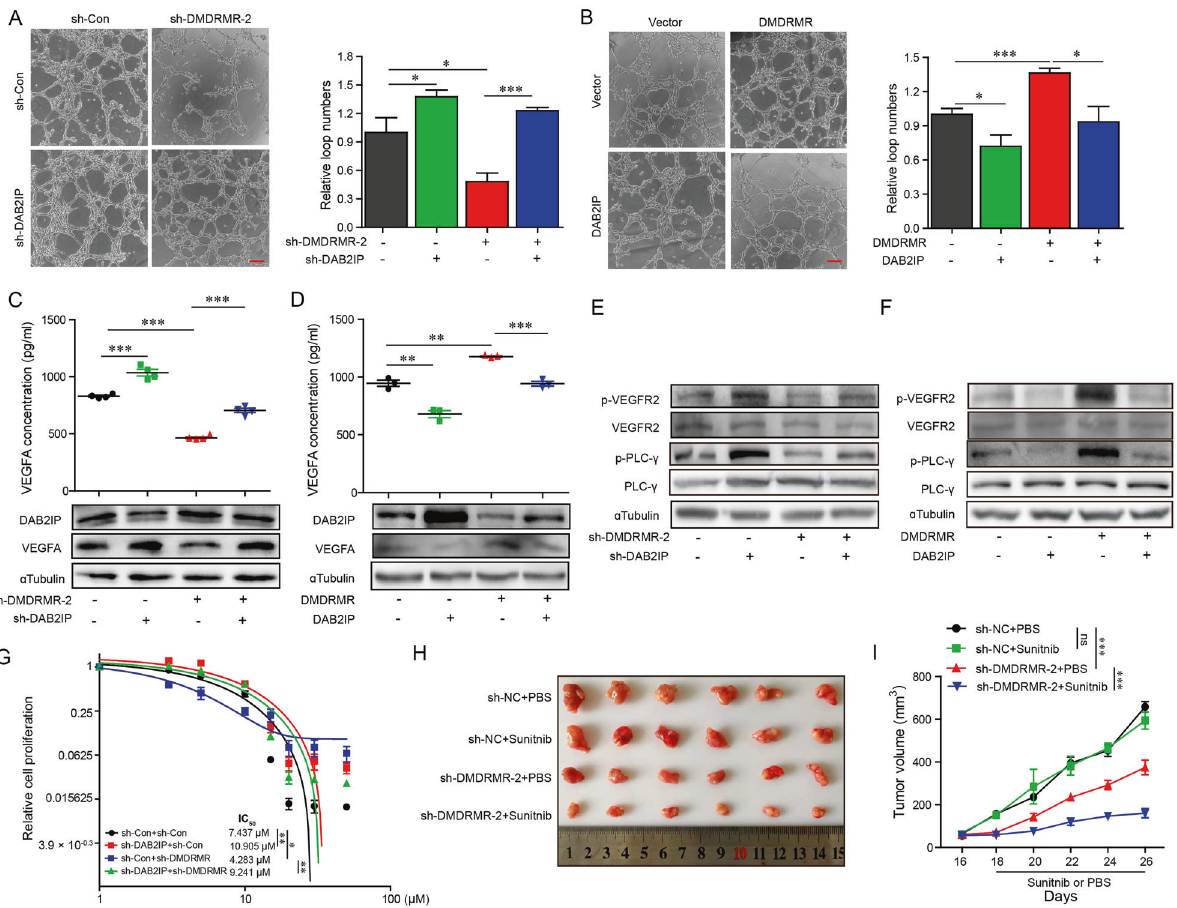
Fig. 7 DMDRMR promotes angiogenesis through the decreased DAB2IP expression. A , B Representative bright- fi eld images (left) and quanti fi cations (right) of matrigel tube formation of HUVECs incubated with conditioned medium from DMDRMR KD 786-O cells with DAB2IP KD ( A ) and DMDRMR OE 769-P cells with DAB2IP OE ( B ) (scale bars, 200 µm). C , D ELISA assay detecting the secreted VEGFA levels in DMDRMR KD 786-O cells with DAB2IP KD ( C ) and in DMDRMR OE 769-P cells with DAB2IP OE ( D ). E , F Immunoblot of VEGFR2, p-VEGFR2, PLC γ and p-PLC